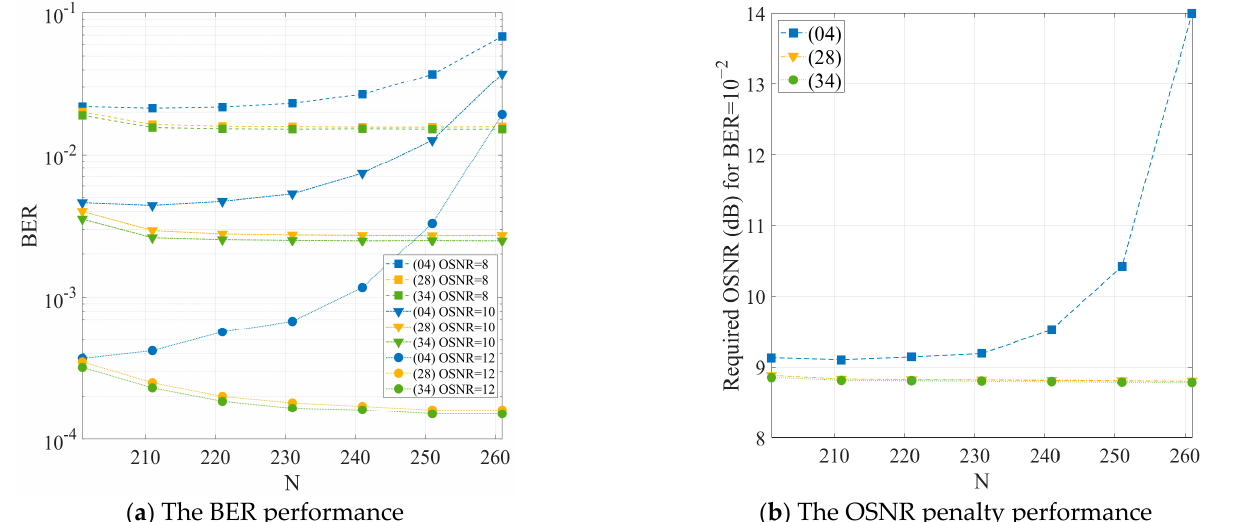
Figure 3. The BER and the OSNR penalty performance of DP-QPSK data with different n values. ( a ) The BER vs. number of coefficients of the CDE filter; ( b ) The OSNR penalty performance vs. number of coefficients of the CDE filter.